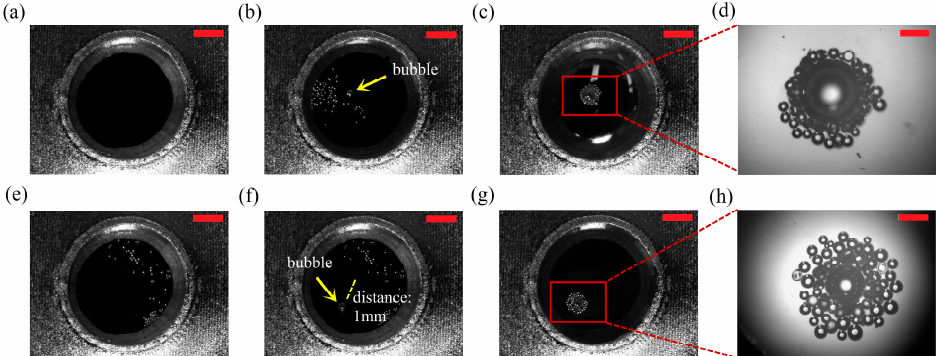
Figure 10. Collection and transportation of micro-objects: ( a ) liquid reservoir; ( b ) first bubble generates on the chip; ( c , d ) vibrated bubble attracts microballs—this manipulation takes about 3 s; ( e ) objects spread after the first bubble is damaged; ( f ) a new bubble appears at new location 1 mm far from the original position; ( g , h ) microballs are re-collected and transported by the oscillated bubble—the collection process takes 4 s. Scale bars in ( a – c ), ( e – g ) are 1 mm, and are 200 µ m in ( d , h ).